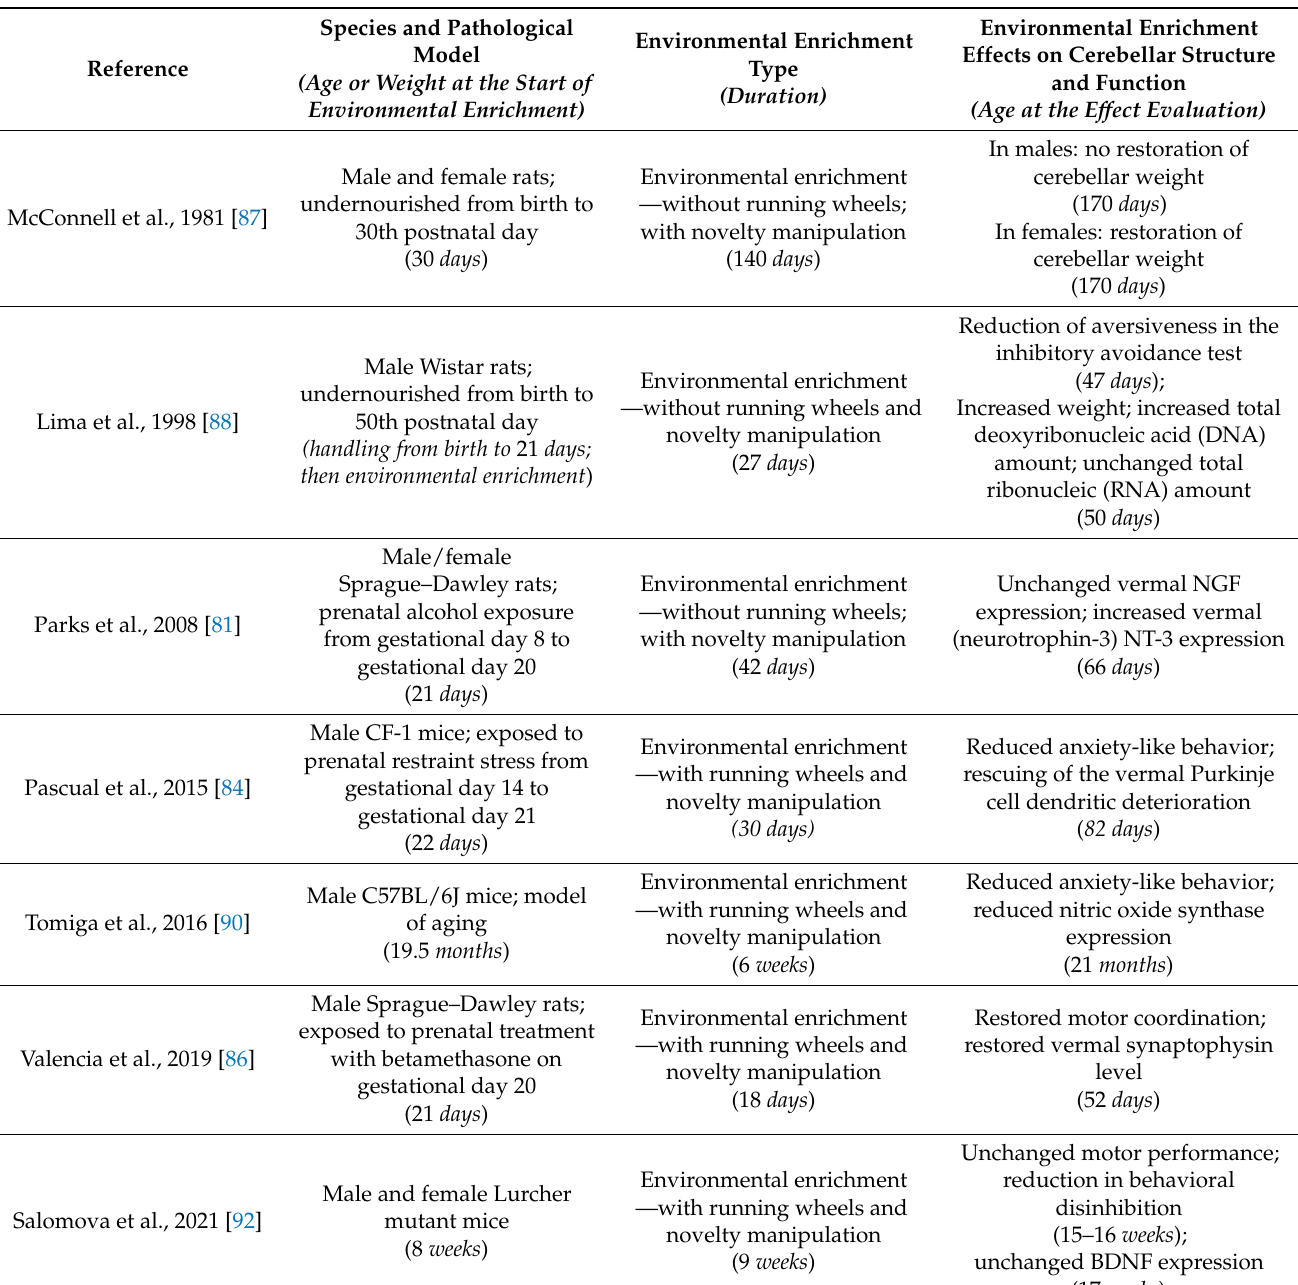
Table 3. Studies on the therapeutic environmental enrichment effects in pathological animal